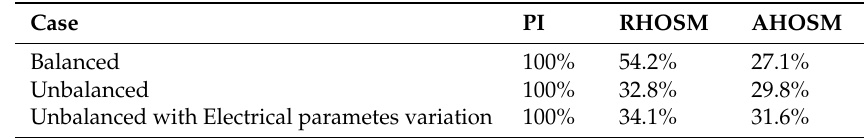
Table 3. RMS of voltages tracking